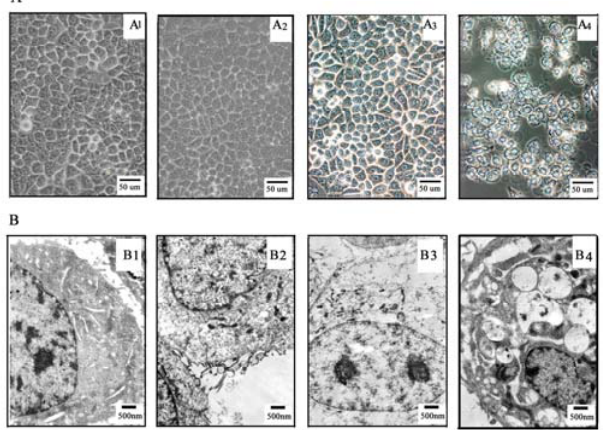
Figure 4. Effect of T α PcZn-PDT on Bel-7402 cells morphology. (A) Bel-7402 cells morphology analyzed by inverted microscope. Bars under each panel represent 50 um. (B) Bel-7402 cells morphology analyzed by Electron microscopy. Bars under each panel or B , control Bel-7402 cells treated with represent 500 nm. Morphology assay in: panel A 1 1 or B , Bel-7402 cells treated with red-light irradiation (53.7 J/cm 2 ); 0.1% DMSO; panel A 2 2 or B , Bel-7402 cells treated with 54 μ M T α PcZn; and panel A or B , Bel-7402 panel A 3 3 4 4 cells treated with 54 μ M T α PcZn in the presence of red-light irradiation (53.7 J/cm 2